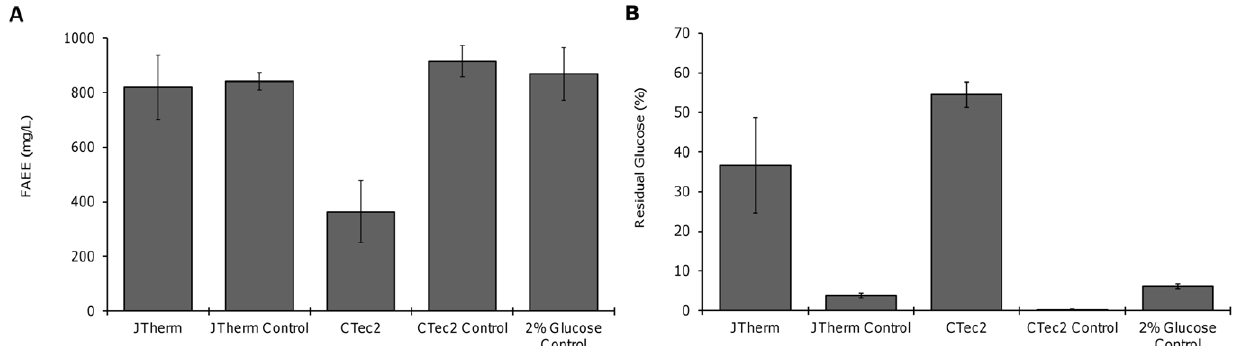
Figure 5. Biodiesel produced by an engineered E.coli strain fed hydrolysates derived from JTherm or CTec2 hydrolysis of IL- pretreated switchgrass. (A), and percentage of glucose remaining after fermentation (B). Glucose levels were adjusted to 2% for all hydrolysates and controls. The JTherm and CTec2 controls contained purified glucose and xylose at the same levels as their corresponding hydrolysate. No xylose was consumed during the fermentation (data not shown). Error bars indicate the standard deviation of triplicate experiments.